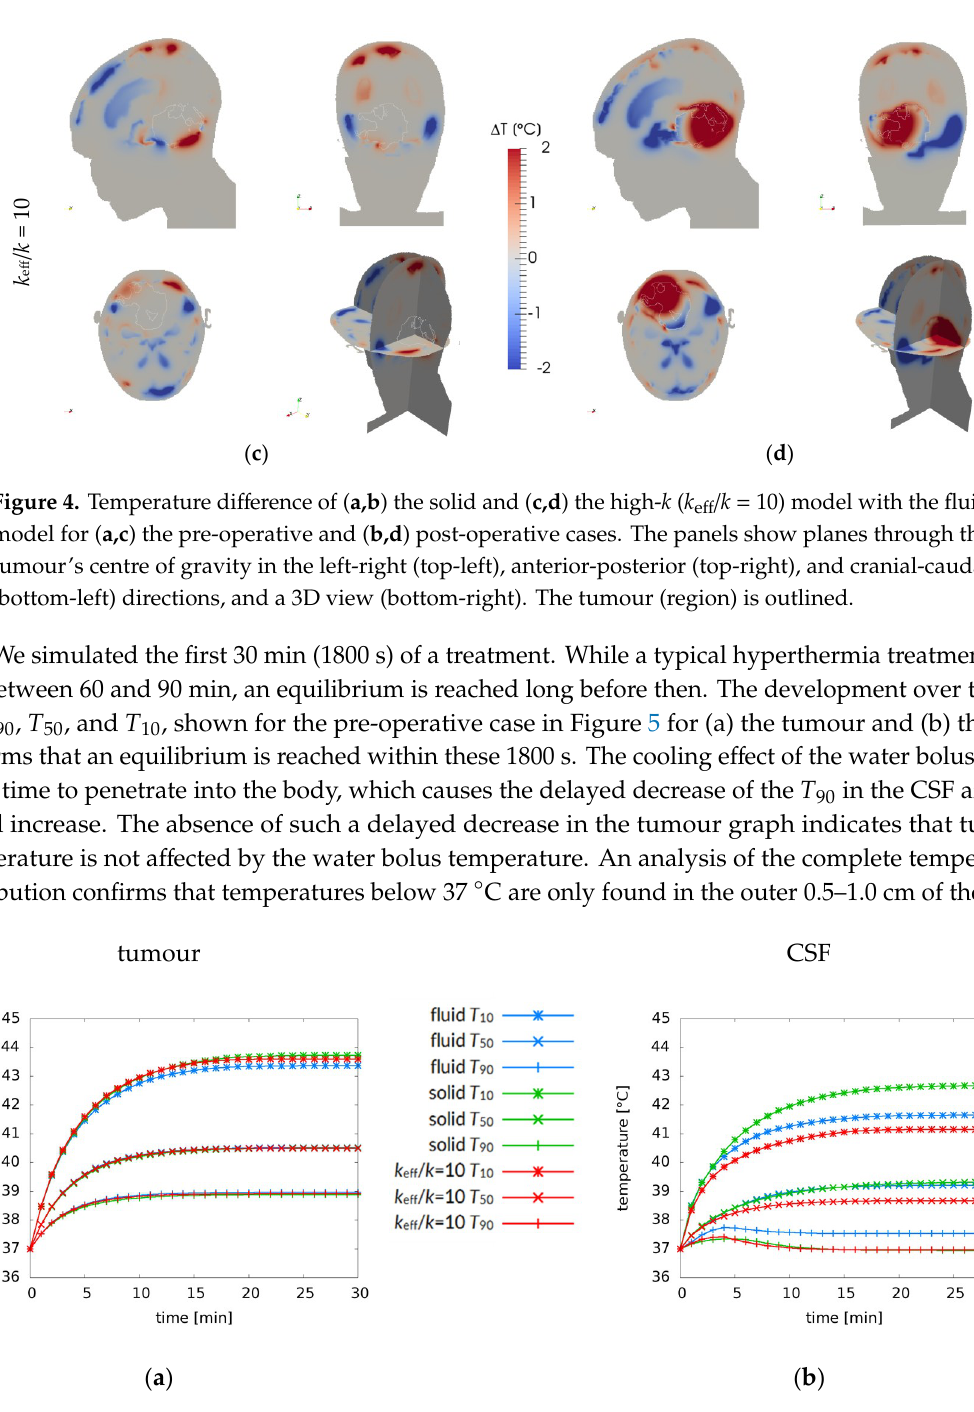
Figure 5. Development of T 90 , T 50 , and T 10 over time for ( a ) the tumour and ( b ) the CSF (pre-operative case) for the fluid model (blue), the solid model (green) and the high- k model ( k eff / k = 10) (red). Initially, the graphs are virtually similar, but after a few minutes the fluid behaviour results in a different temperature profile. While the temperature increase starts slowing down after about five minutes, it takes about 25 minutes to reach the equilibrium situation. Figure (b) also shows the cooling effect of the water bolus on the T 90 .